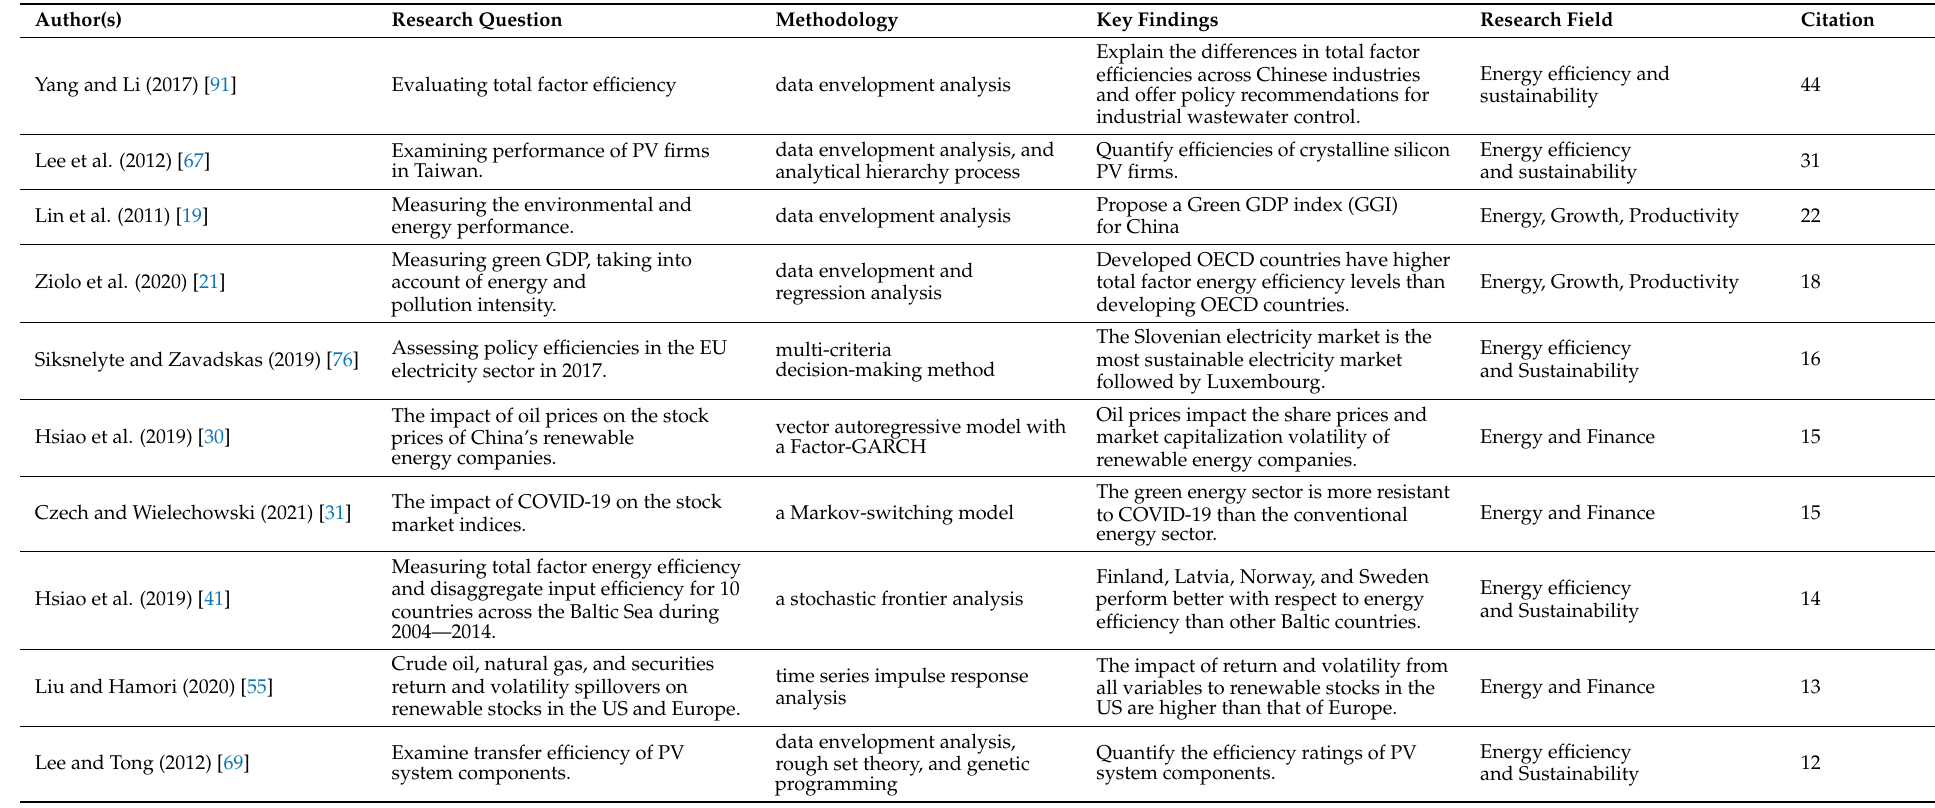
Table 6. Ten most cited articles in Energies related to economic aspects of the energy